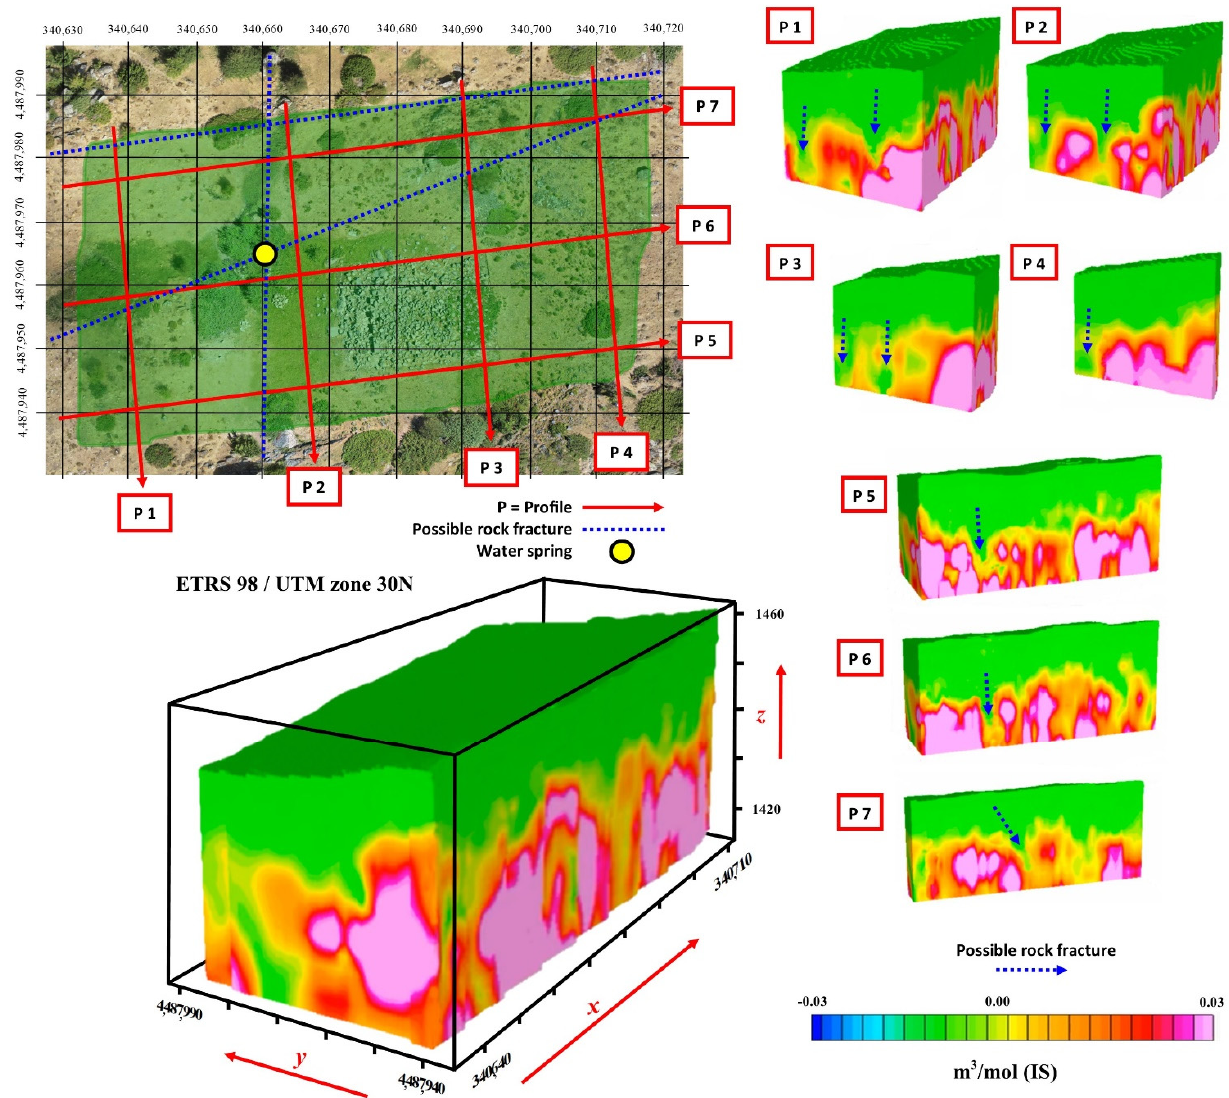
Figure 8. Results derived from the magnetometric 3D (magnetic susceptibility), Gaussian scale.